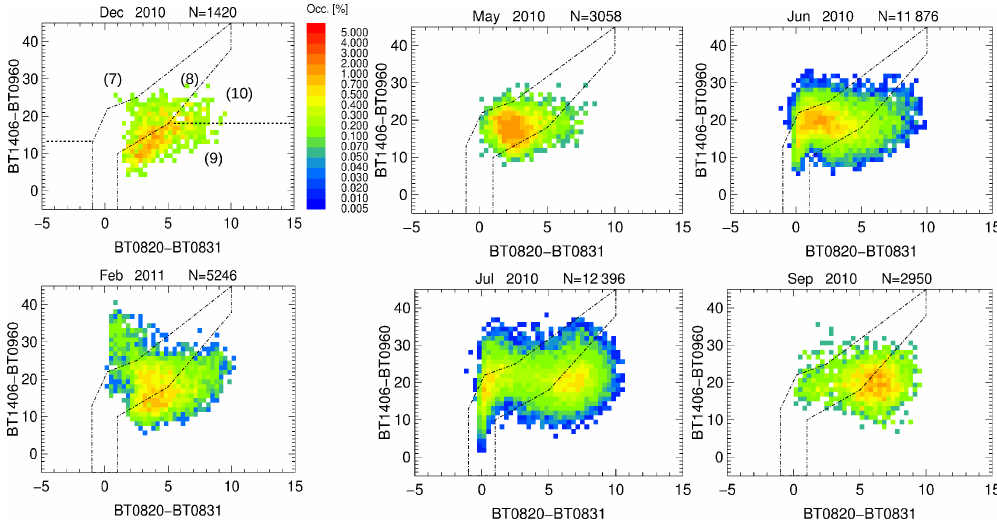
Figure 7. Monthly PDFs of BTD 820 − 831 vs. BTD 1406 − 960 from MIPAS for NH December 2010 and February 2011 (left column, like in Fig. 3) and SH May, June, July and September 2010 (middle and right column, like in Fig. 3) in the altitude range 16–30km. The colour code represents the relative occurrence in percent with respect to the total number of cloudy spectra ( N obs ) with CI < 5 for each individual spectrum observed north and south of 55 ◦ N/S respectively. The dashed dotted polygon highlights regions (7)–(10) for various PSC compositions retrieved from the CSDB: region (8) represents the area of STS occurrence (Fig. 6) but may overlap with large ice and large NAT particles and is also indicated with the acronym l ICE5_STS_ l NAT3 in Table 2. The two horizontal lines (dashed) in this diagram create three additional areas where in region (7) small ice ( s ICE5) dominates, in region (9) medium-sized NAT particles ( m NAT) dominate, and in region (10) small NAT particles ( s NAT2) dominate the distribution.